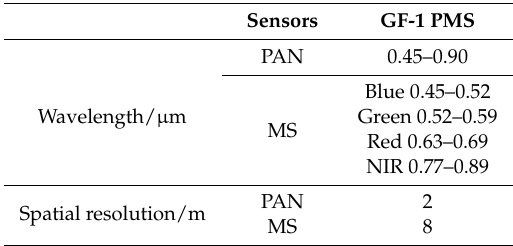
Table 1. Characteristics of GF-1PMS data.